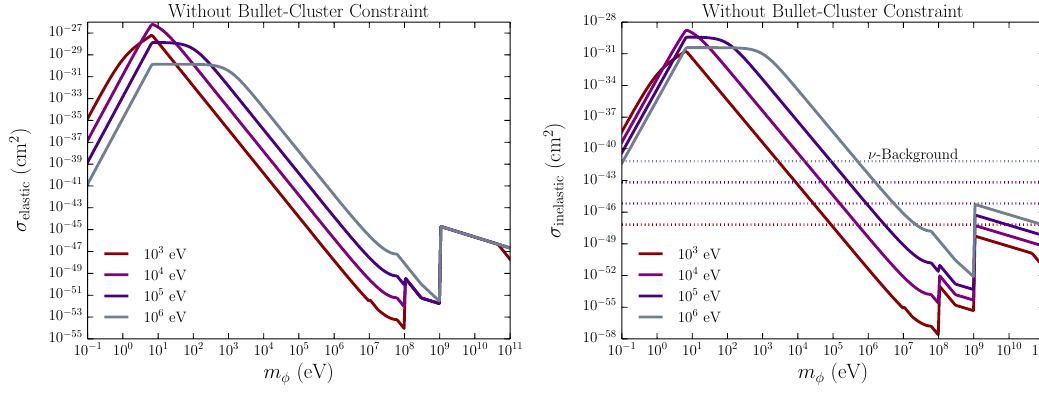
Figure 5 . Left: limits on dark matter-nucleon elastic cross-section assuming no bullet cluster limit, shown as a function of mediator mass for various dark matter masses assuming that we exclude (cid:1) N e(cid:11) = 0 : 09 with future CMB data. Right: limits on the dark matter-nucleon inelastic cross-section assuming no bullet cluster limit, shown as a function of mediator mass for various dark matter masses, using A = 130. We also assume (cid:1) N e(cid:11) = 0 : 09 is excluded with future CMB data. The dotted lines show the neutrino background expected for the same momentum transfer as a dark matter part of the appropriate mass. Note that without the bullet cluster, there are regions of m (cid:30) and m dm that produce a conventional cosmology but produce cross-sections above the neutrino (cid:13)oor. choose the coupling between (cid:31) , (cid:30) and ’ so that ’ and (cid:31) are in equilibrium with each other only after (cid:30) has decoupled from the Standard Model - the entropy dump during the QCD phase transition allows (cid:30) to be colder than the Standard Model, diluting the